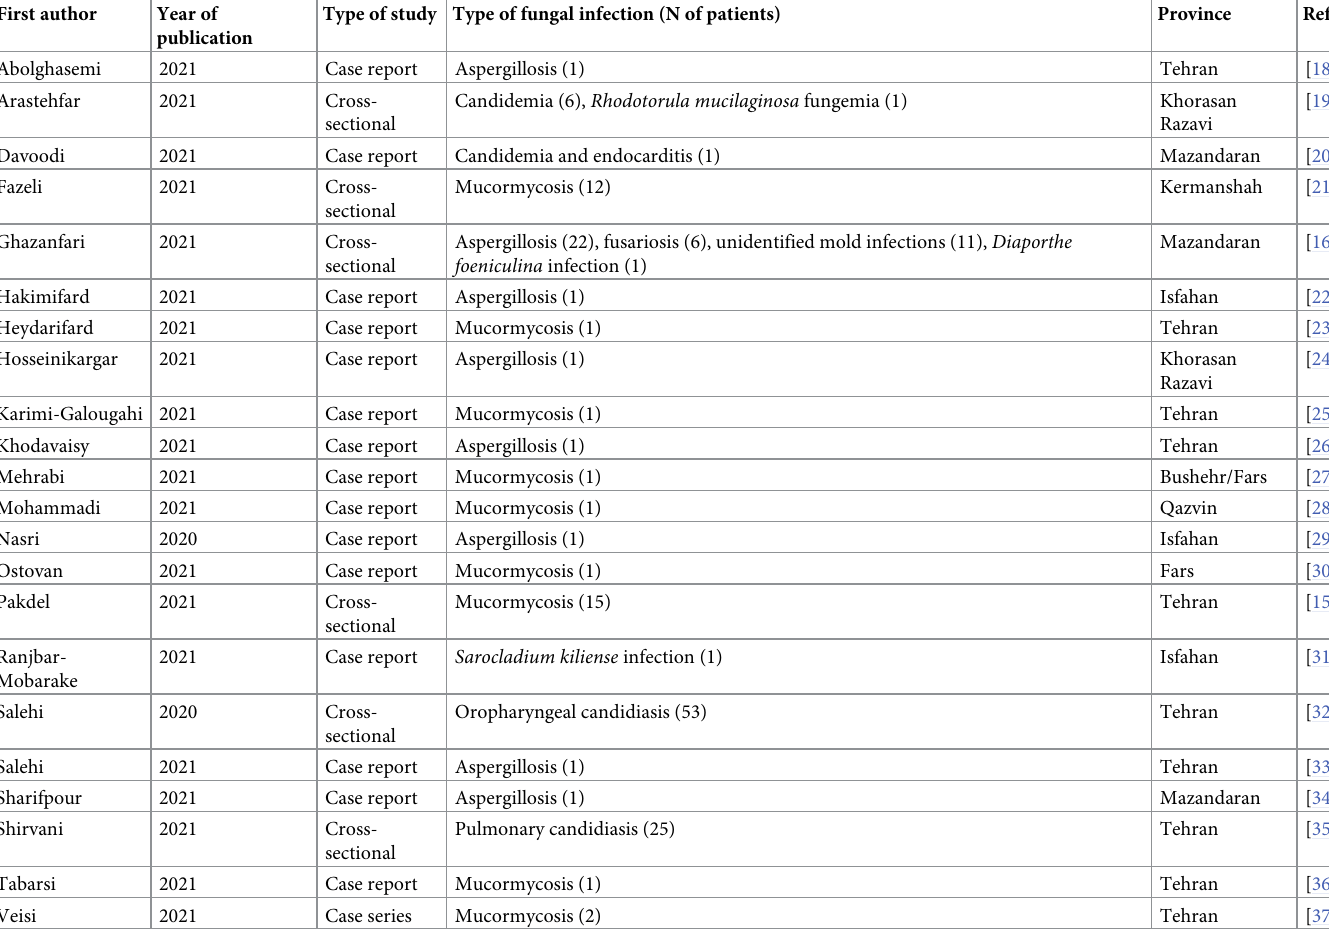
Table 1. Details of 22 studies with data of COVID-19-associated fungal infections among Iranian patients published up to November 5,